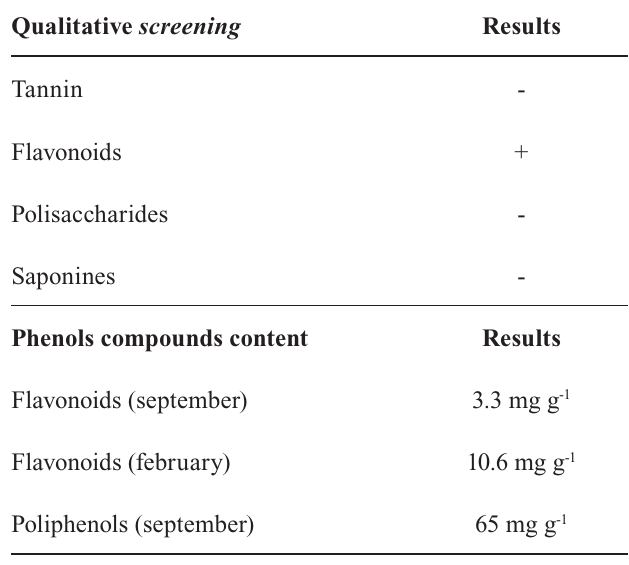
TABLE II - Qualitative screening and content metabolites present in the CEE from T.